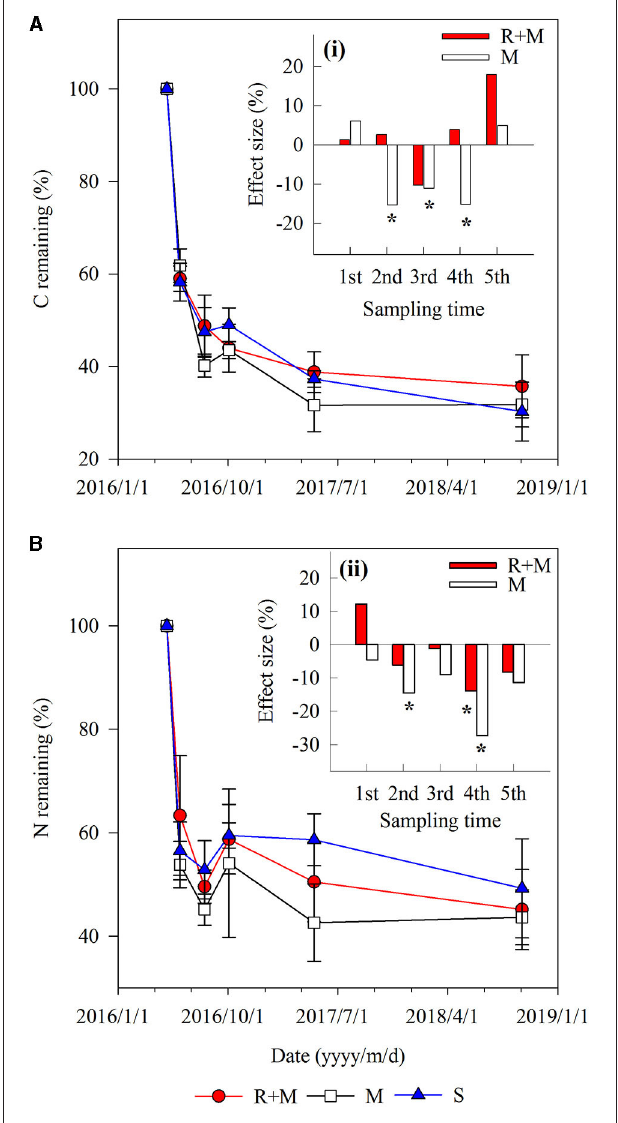
FIGURE 4 | Carbon and nitrogen remaining during decomposition for fine roots of A. halodendron under the following three treatments: fine roots and mycelia (R + M), mycelia (M), and bulk soil (S). Values represent M ± SD . The small bar plot inset top-right indicates the effect size of R + M (red bar) and M (white bar) compared with S for C remaining (A) and N remaining (B) . Bars labeled with * indicate significant differences ( P < 0.05) compared with the S treatment.